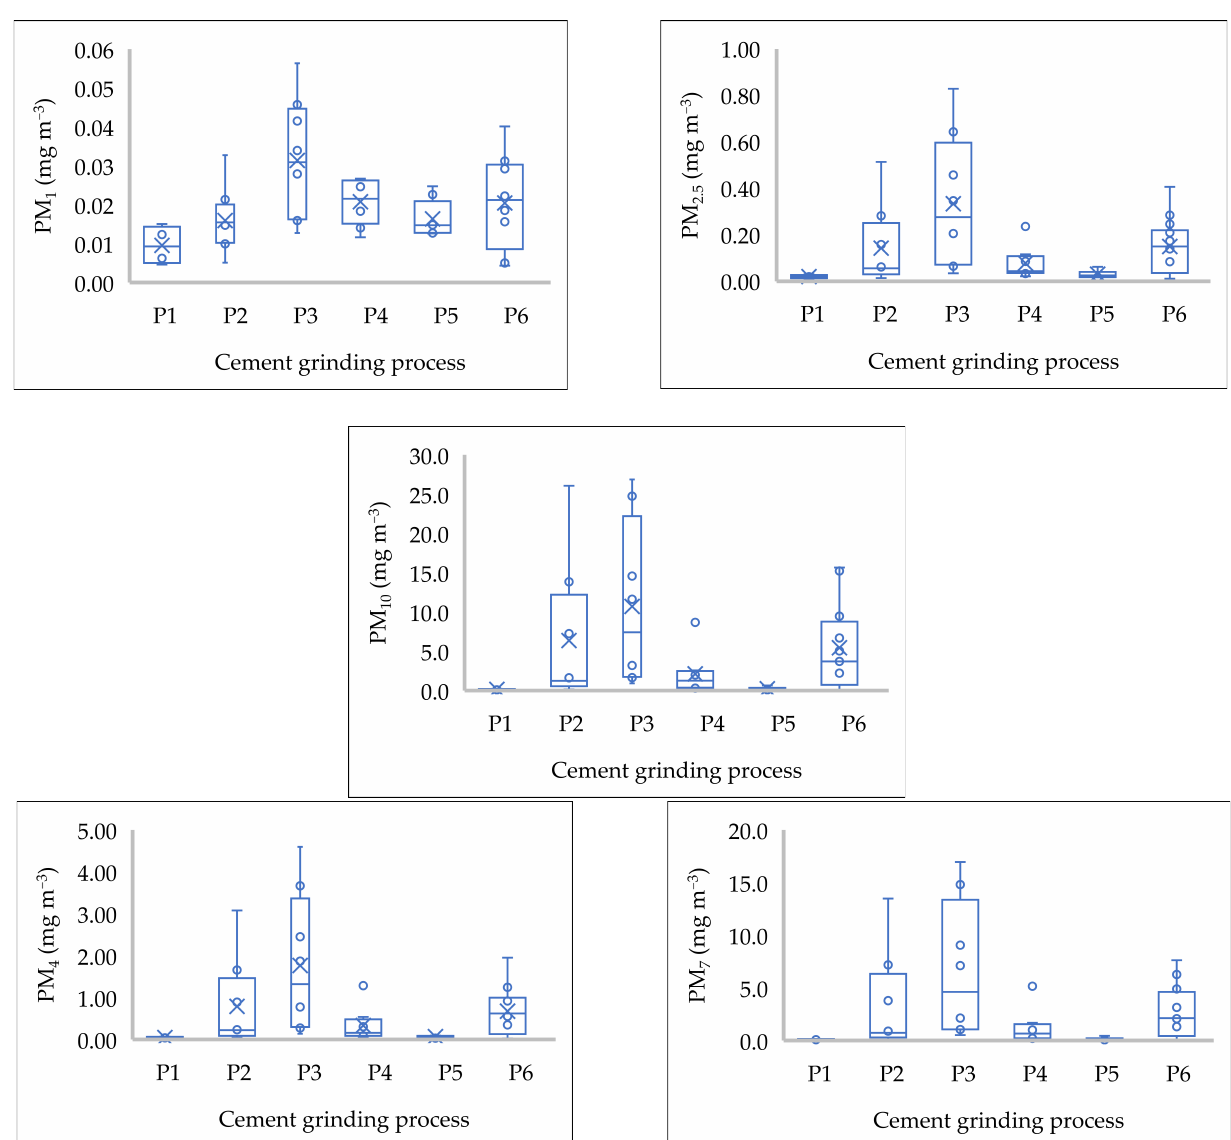
Figure 3. PM 10-7-4-2.5-1 distribution in the cement grinding processes. The measurement results divided the PMs into two principal groups: coarse particles, mostly larger than 2.5 µm in aerodynamic diameter, and fine particles, mostly smaller than 2.5 µm in aerodynamic diameter (PM 2.5